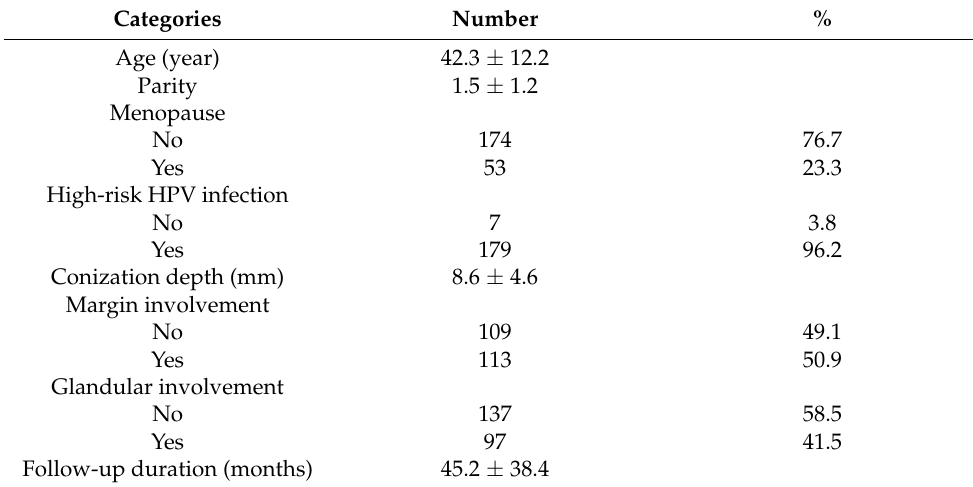
Table 1. Clinical characteristics of the study population ( n = 234).